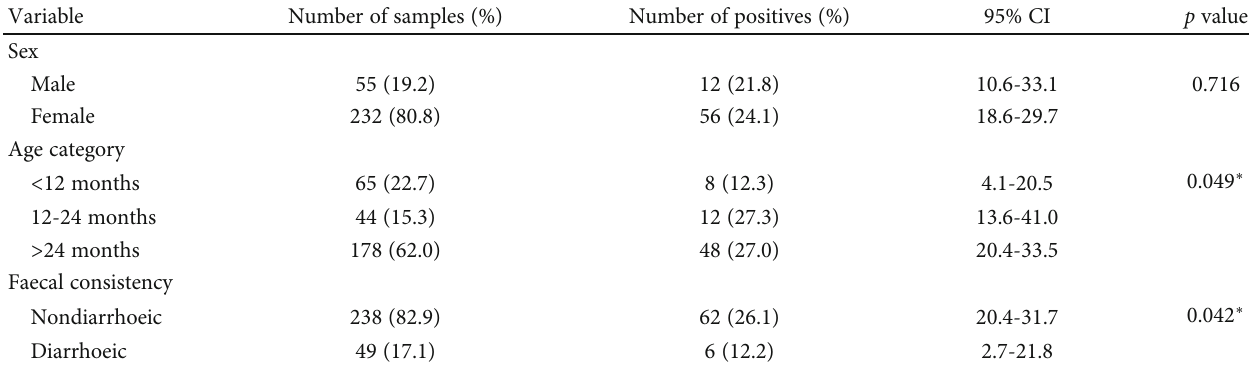
Table 1: Occurrence of Cryptosporidium infection in cattle by sex, age, and faecal